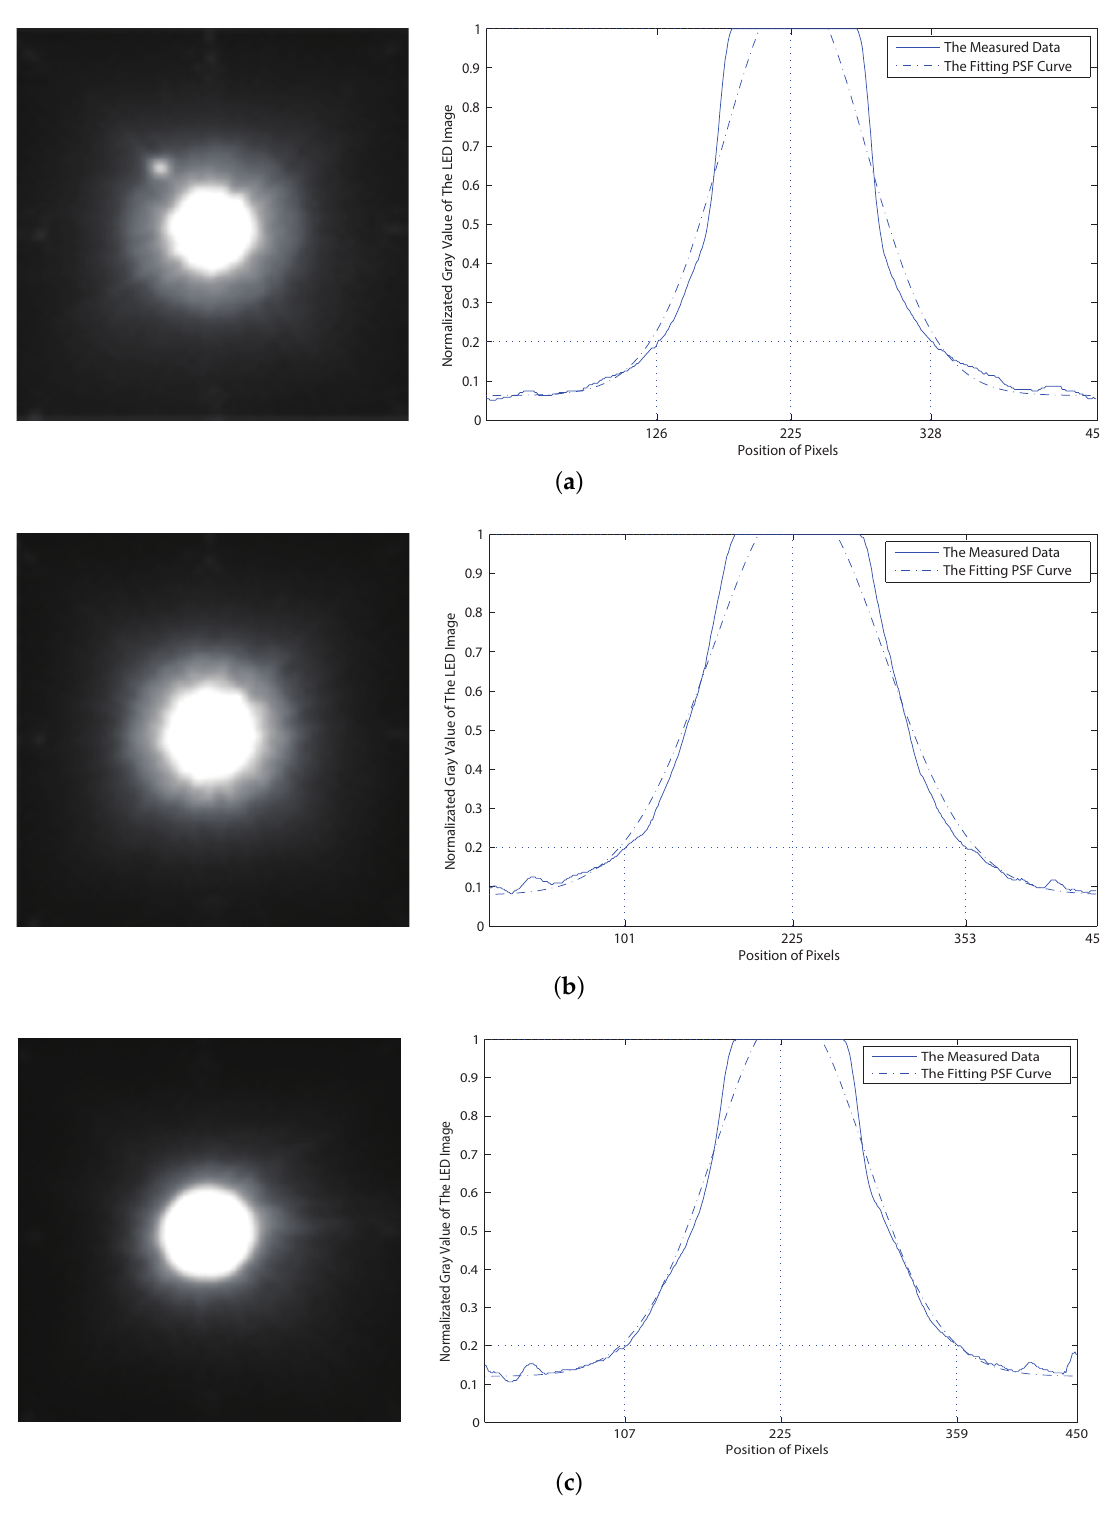
Figure 9. The imaging results of three different lenses under the same photography